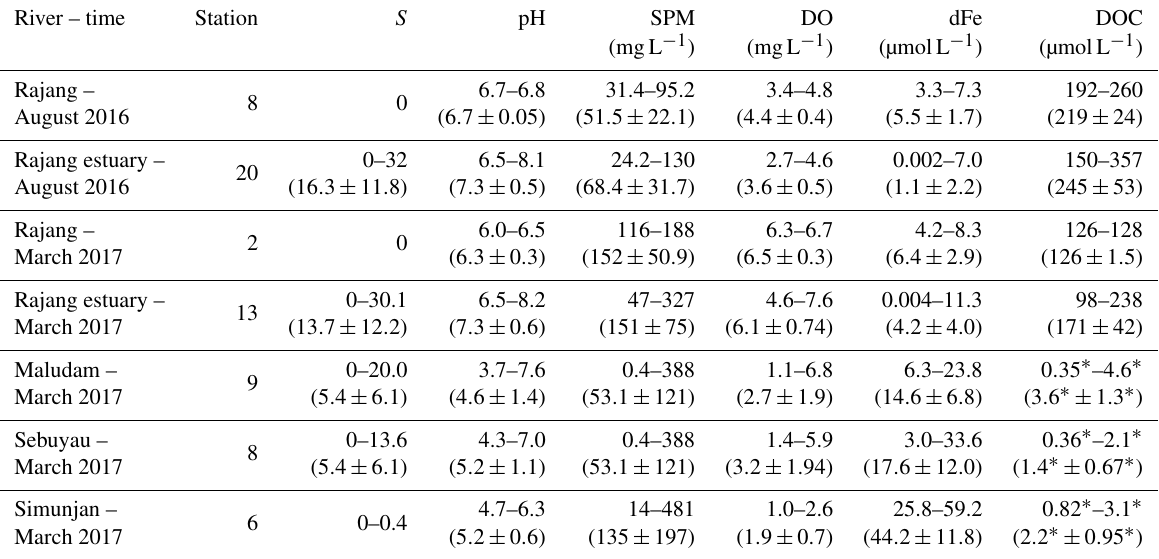
Table 1. Range and average of salinity ( S ), pH, suspended particulate matter (SPM), dissolved oxygen (DO), dissolved iron (dFe) and dissolved organic carbon